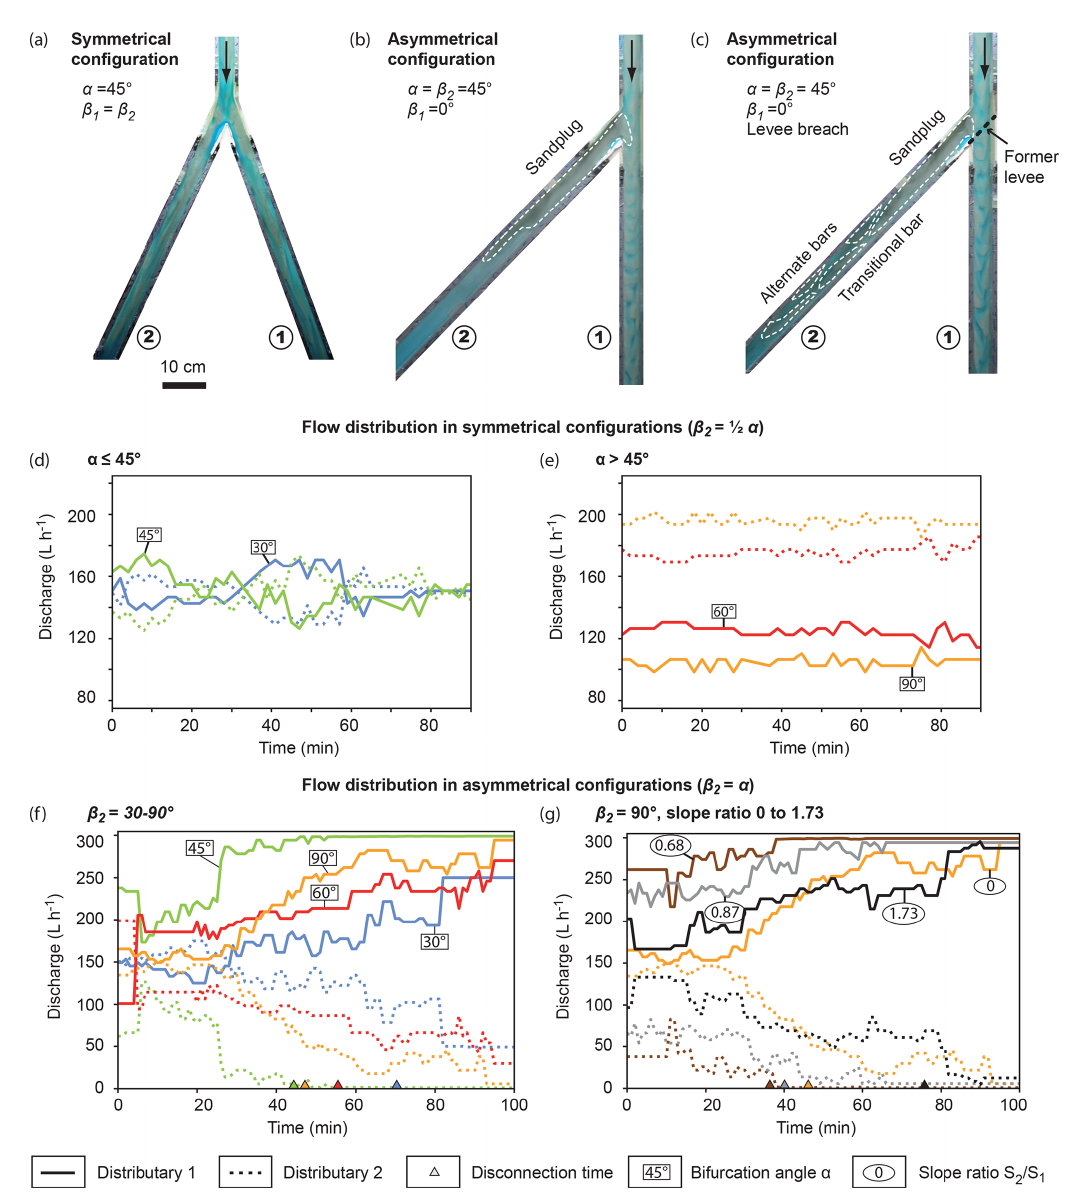
Figure 3. Evolution of the experiments. (a–c) Overhead pictures of the setup for symmetrical (a) and asymmetrical configurations without (b) and with levee breach (c) . (d–f) Evolution of water discharge measurement at the output of the distributary channels for symmetrical (d–e) and asymmetrical (f–g) configurations. (g) Asymmetrical 90 ◦ configurations with varying slope ratios S 2 /S 1